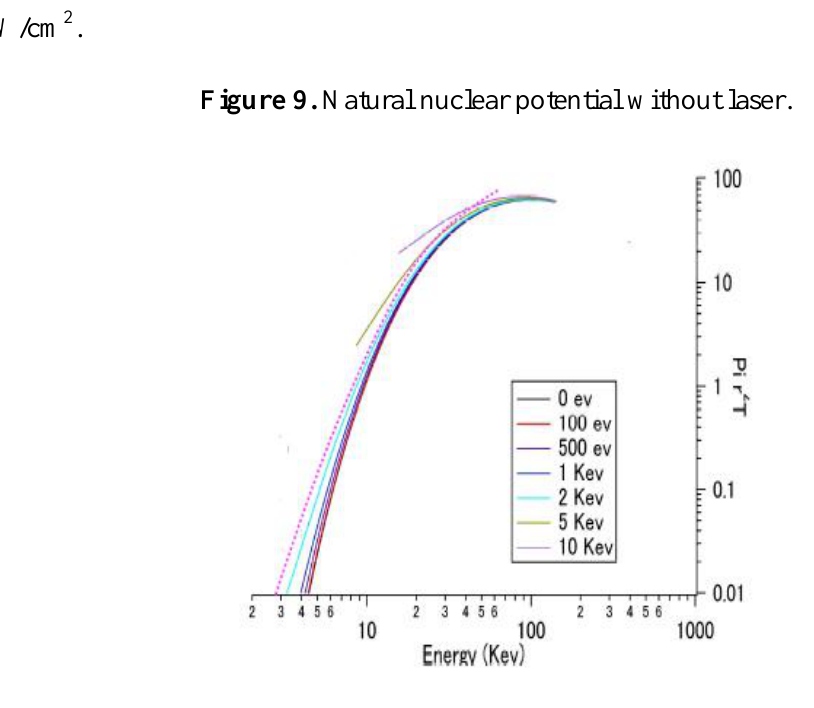
Figure 10. Heisenberg uncertainty of the nucleon energy during the tunneling and Coulomb barrier level with laser in Figure